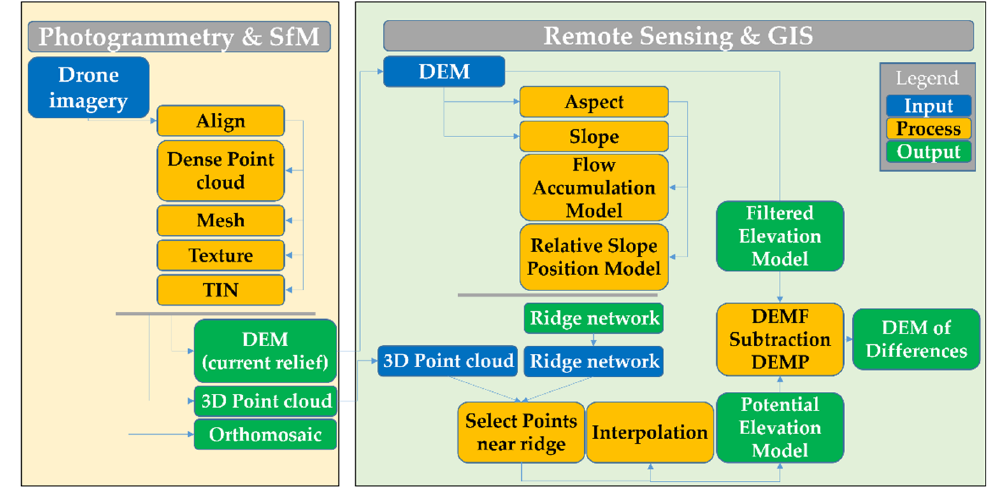
Figure 3. Comprehensive workflow of the described methodology, starting from the drone imagery and its Structure from Motion (SfM) processing, following with the obtention of the intermediate products (DEM of the current relief, 3D point cloud and orthomosaic), the GIS treatment of the DEM to obtain the ridge network, the estimation of the DEM before the erosive processes and the DEM of Differences (DoD) between the current relief DEM and the estimated original DEM.